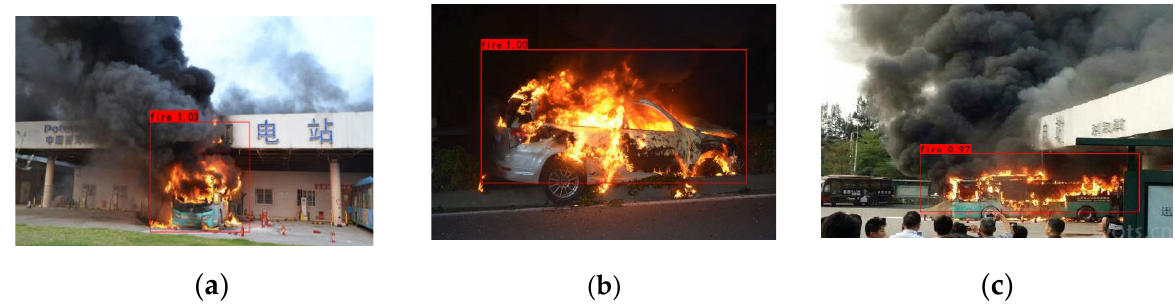
Figure 13. Test results YOLOv3. ( a ) Sufficient light; ( b ) Insufficient light; ( c ) Long-range target.